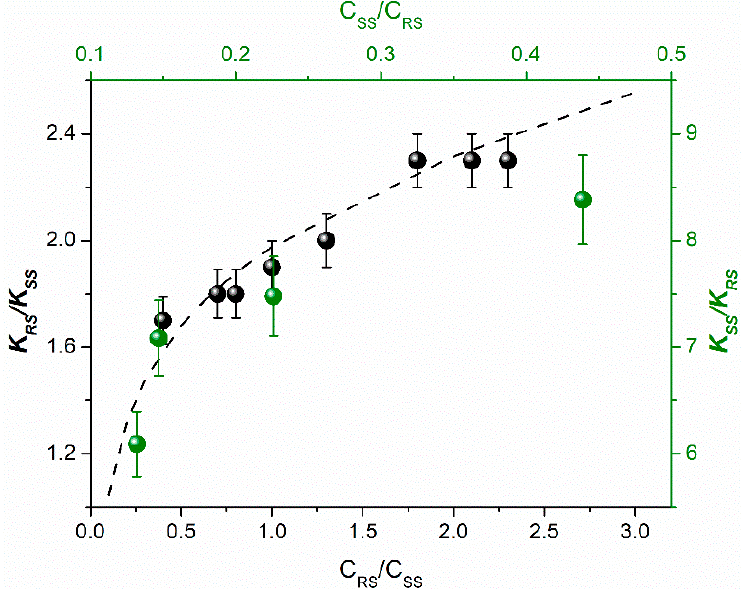
Figure 4. The experimental dependence of the observed ratios of CIDNP enhancement coefficients and calculated values (dash line) on ( R,S )-diastereomer concentration for dyads IV (black balls, C SS = 1 mM) and II (green balls, C SS = 2 mM) [14,20].